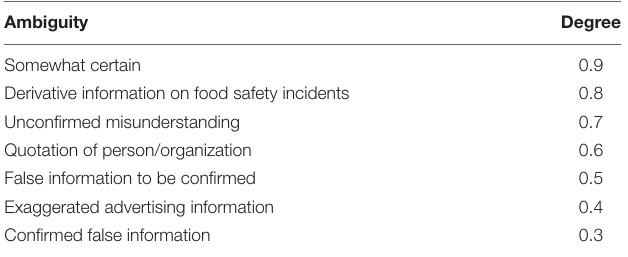
TABLE 4 | The assigned degree of ambiguity of anti-rumour